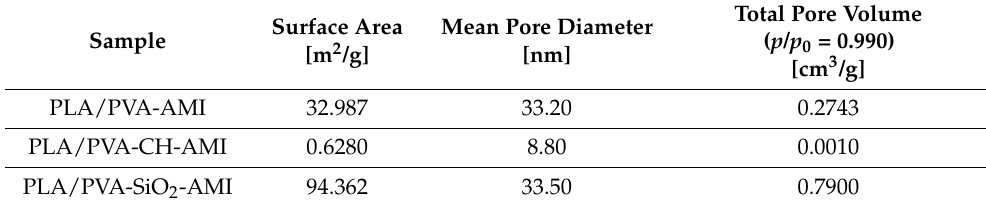
Table 3. Results of BET analysis for PM.